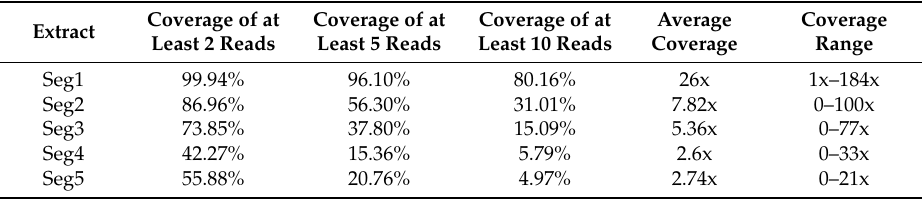
Table 5. mtGenome coverage for small fragments in recent hair R7*. The asterisk denotes extraction using protocol B. This mapping used revised Cambridge Reference Sequence (rCRS) as a reference to avoid gaps due to short reads that could either map to the mtGenome or to the nuclear genome